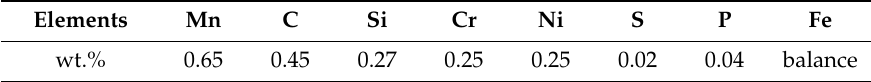
Table 1. The C45E substrate chemical composition (wt.%).